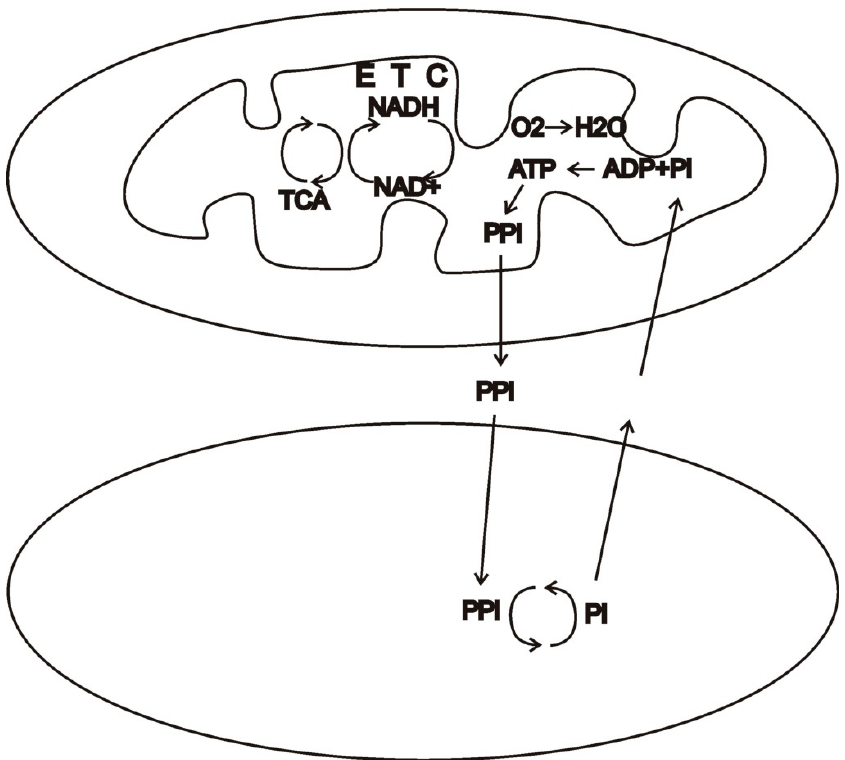
Figure 1. Simplified schemata of a possible aerobic interaction between a protomitochondrion and a proto-host. The protomitochondrion (top panel) uses the Krebs or TCA cycle to oxidize substrate and reduce NAD + . NADH is re-oxidized by the electron transport chain (ETC) while oxygen is reduced to water and ATP forms from ADP and P i . Under favorable conditions, the protomitochondria exports PP i to maintain state 3 metabolism [21]. This export may be triggered by an increase in ROS, which are then maintained at moderate levels [7]. PP i may be taken up and metabolized by the proto-host, which in turn exports P i .